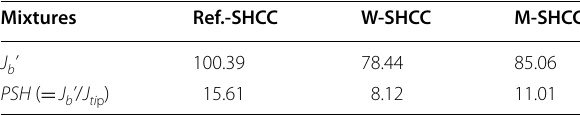
’ value and PSH index b